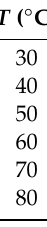
Figure 15. Comparison of U ge at different temperatures. Table 5. Table of actual values of V m as a function of temperature.